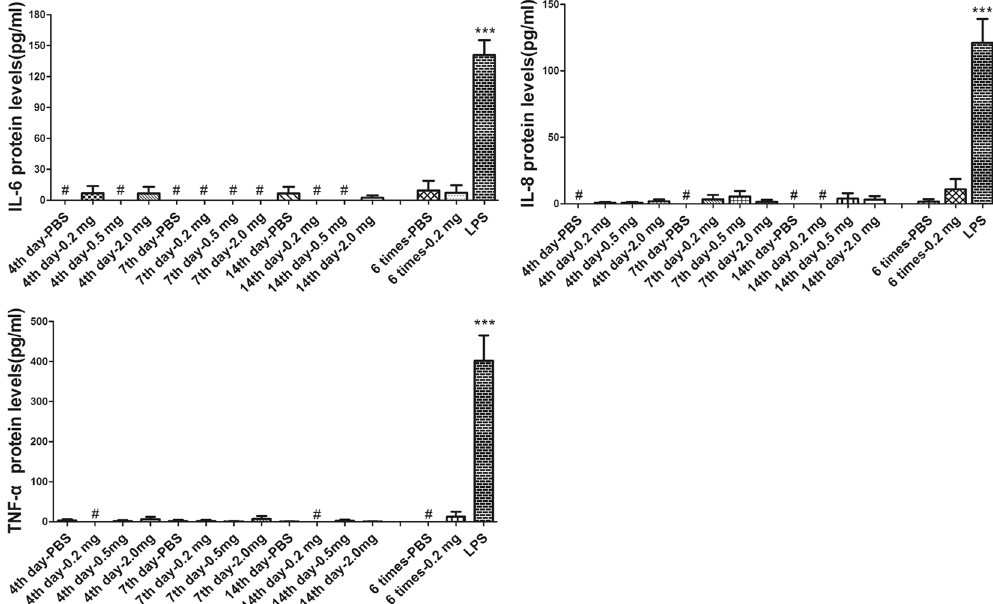
Figure 6. Protein levels of IL-6, IL-8 and TNF- α in the aqueous humor. Samples were collected on the 4 th , 7 th , 14 th day after single injection of 50 μ L PBS or 0.2 mg, 0.5 mg, 2.0 mg of conbercept and on the 7 th day after the 6 th multiple injections of 50 μ L PBS or 0.2 mg of conbercept as measured by ELISA. Positive control was collected 24 hours after injection of 100 μ g of LPS. No statistically significant difference was found among the conbercept- injected groups and the PBS-injected groups. The protein levels of the three inflammation cytokines in the LPS-injected groups were significantly higher than all the other groups ( p < 0.001). The results are mean ± SEM (n = 3~4). #